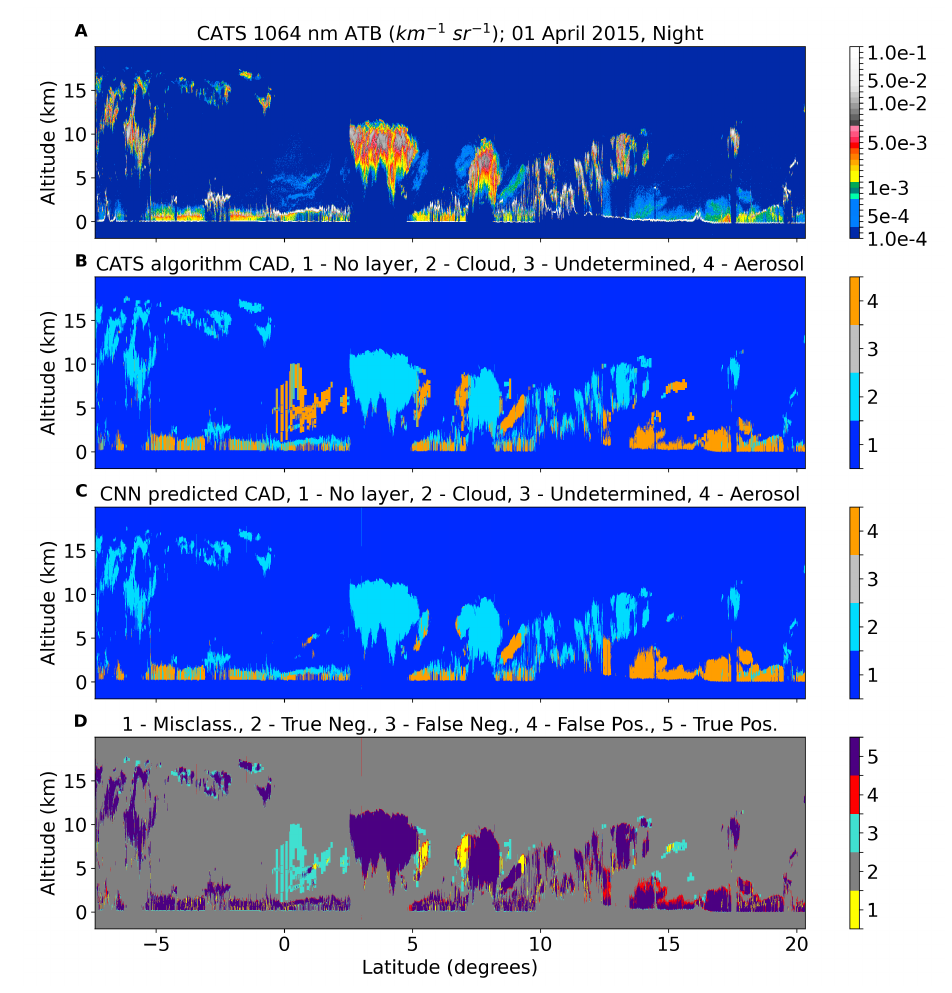
Figure 11. A CATS nighttime case on 1 April 2015 with the same four plots as Figures